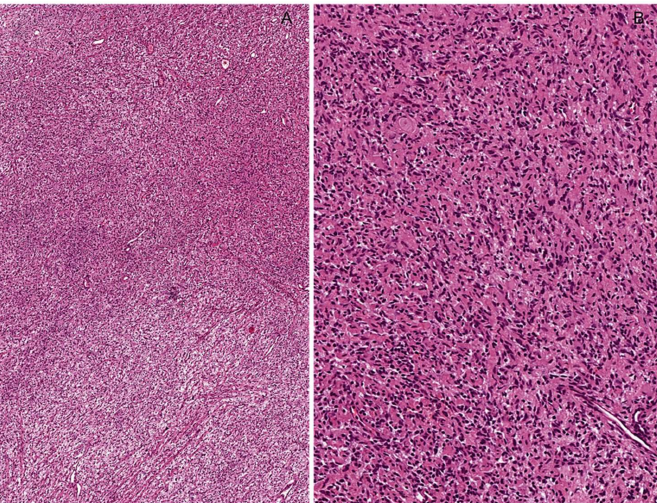
Figure 8. Cellular Neurofibroma. ( A ) Low-magnification image of a hypercellular tumor with a fascicular arrangement of the neoplastic cells. ( B ) The absence of cytological atypia and mitoses is against the diagnosis of